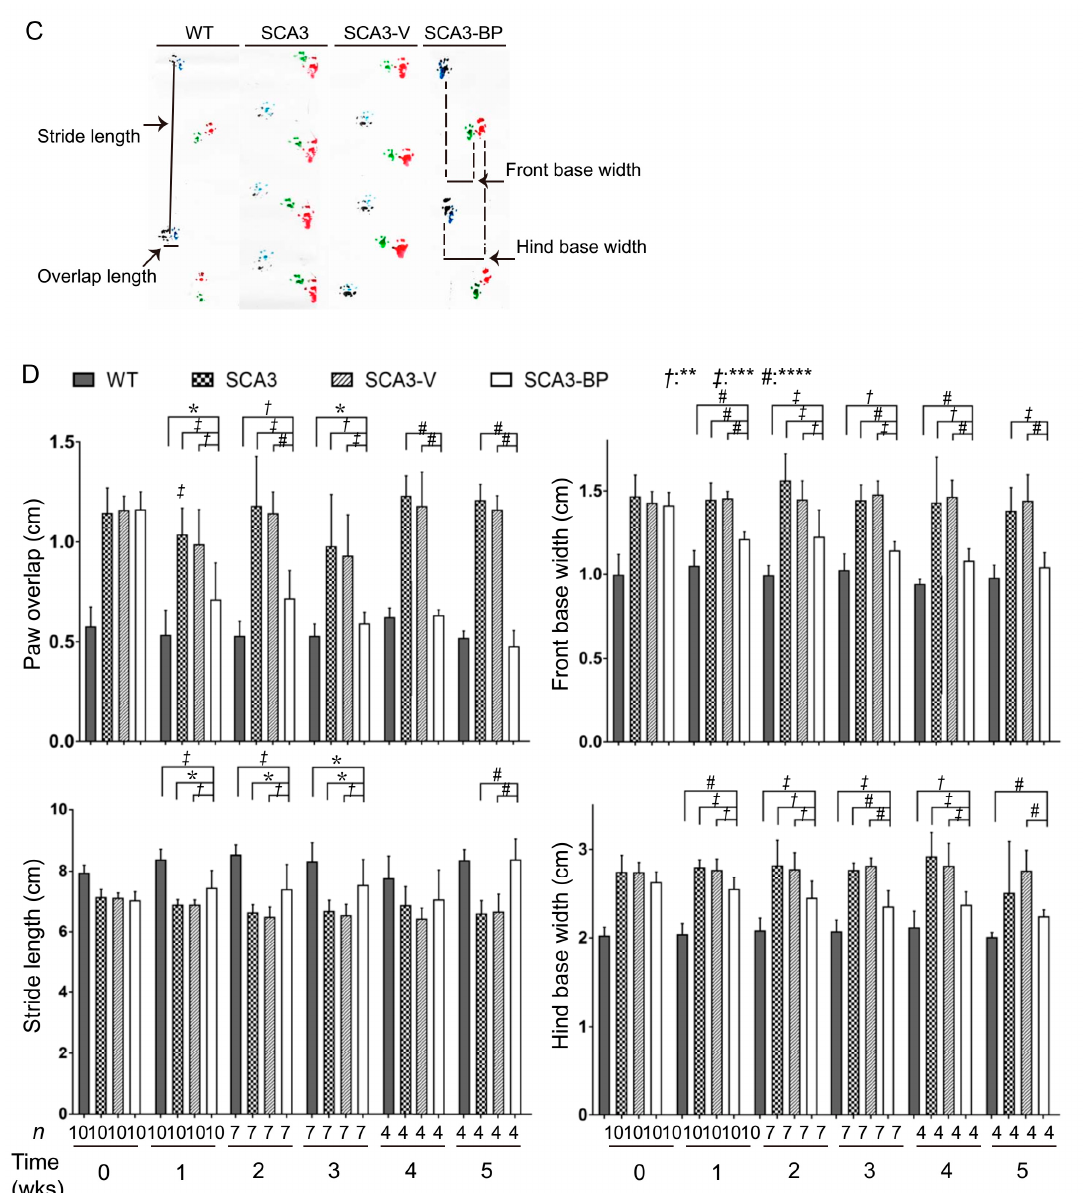
Figure 1. Administration of n -BP significantly alleviated impairments of motor coordination and ameliorated gait/locomotion in the SCA3 mouse model. ( A ) The representative designed study showing 23-week-old wild-type and SCA3 mice were divided into four groups (each n = 10 at the beginning): WT, SCA3, vehicle, or n -BP (50 mg/kg b.i.d.) treated with SCA3 (SCA3-V or SCA3-BP) for 5 weeks. Behavior studies were performed every week, and the studied animals were euthanized at first, third, and fifth weeks for sample collection and indicated analysis. ( B ) A significantly improved motor coordination of the n -BP treated SCA3 mice in accelerating (0–40 r.p.m. within 5 min) rotarod test was recorded. The n -BP treated SCA3 mice had better motor performance and balance compared to SCA3’s non-treated and vehicle groups. Asterisk presents the calculated p value of SCA3-BP versus WT or SCA3-V. To figure out the best response to n -BP during the treatment, small groups of 1–2 mice were additionally prepared for the behavioral evaluation at the sixth week. ( C , D ) Representative images of footprint patterns displaying the gait of n -BP administered SCA3 mice were similar to WT animals at the fifth week (28-week-old mice). Based on the 5 weeks’ footprinting test, SCA3-BP group presented improved coordination with shorter footprint overlap and longer stride length than vehicle or non-treated animals. Moreover, the long front and the hind base width in SCA3 and SCA3-V groups were presented. The 5 weeks of n -BP treatment made a significant improvement on balance of SCA3 mice (†: **, ‡: ***, #: ****). Animal number for the statistics was indicated as n . Data represent mean ± s.d.; * p < 0.05, ** p < 0.01, *** p < 0.001, **** p < 0.0001 (Student’s t -test).